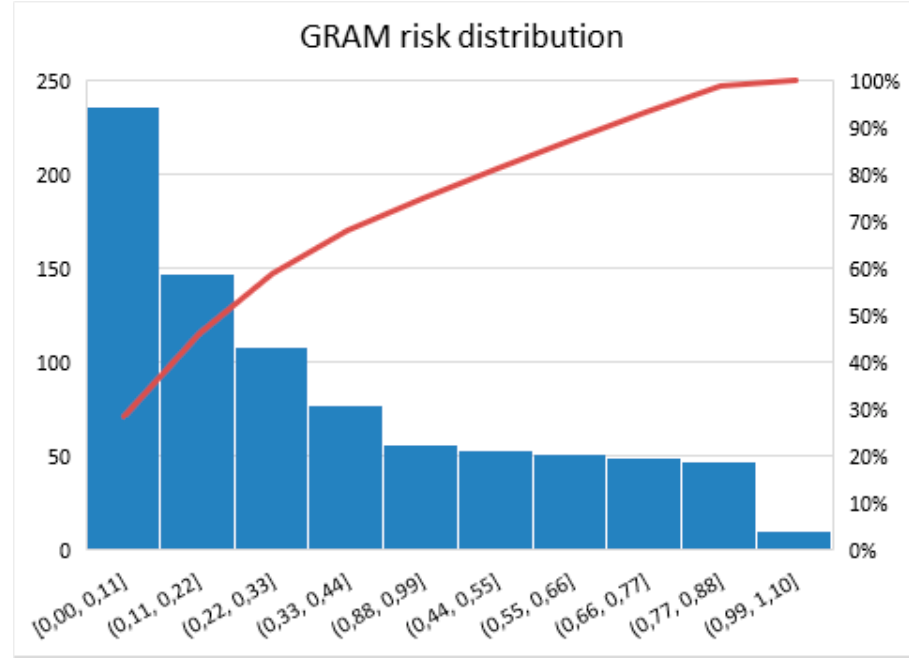
Figure 2. Pareto chart shows the percentage distribution of patients according to risk stratification on the GRAM score in patients with COVID-19 infection. The red line indicates the cumulative number (in percent) of patients with GRAM scores in each range.